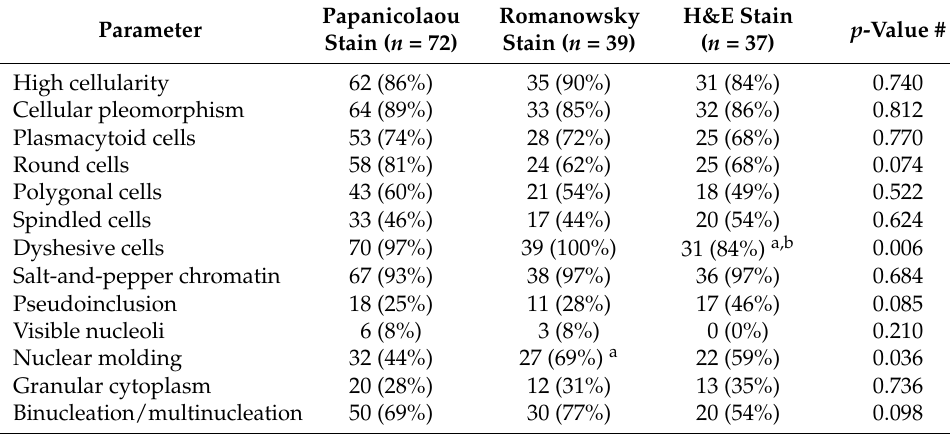
Table 2. Cytomorphologic characteristics by different staining methods (accurately categorized specimens, total n = 148).